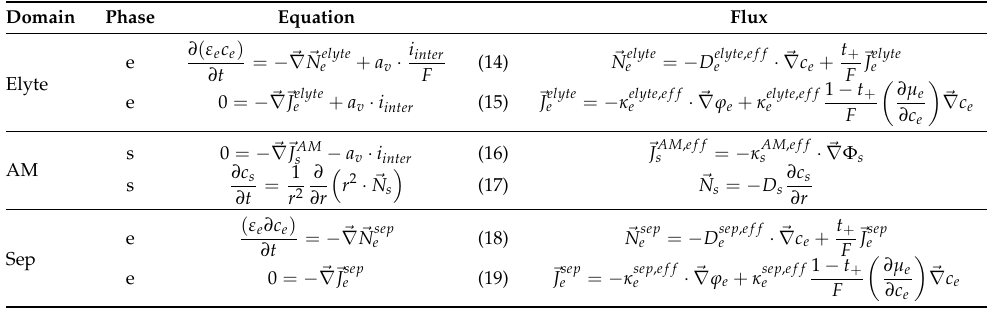
Table 2. List of governing equations used for the homogenized electrochemical